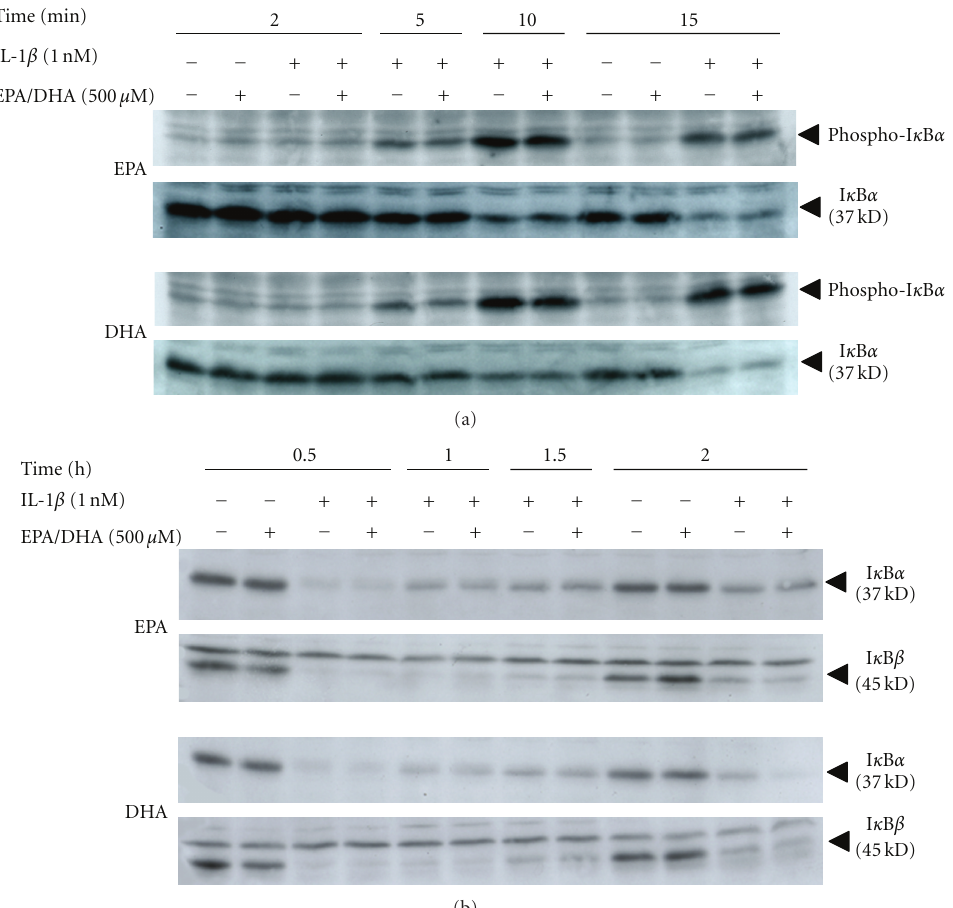
Figure 10: E ff ects of peroxidized EPA/DHA on the phosphorylation and degradation of I κ B proteins. Cells were treated with IL-1 β (1nM) in the presence or absence of peroxidized EPA for 3 days and DHA for 1.5 days (each, 500 μ M) for the indicated times. (a) Phosphorylation and degradation of I κ B α , and (b) degradation and recovery of I κ B α and I κ B β . Cell lysates (25 μ g of protein) were subjected to SDS-PAGE in a 12.5% gel, followed by immunoblotting with an anti-phospho-I κ B α , anti-I κ B α or anti-I κ B β antibody.